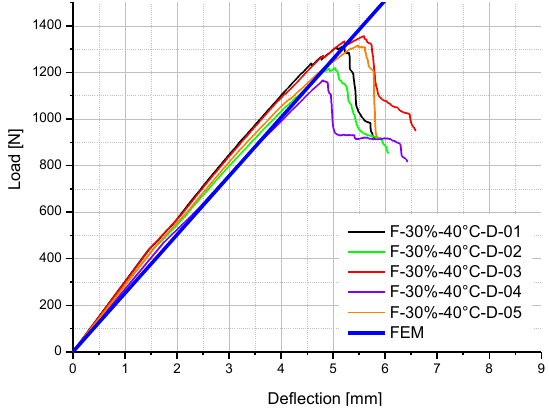
Figure 13. Comparison of experimental and FE results on the load-deflection curve of F-30%-40 °C-D specimens.